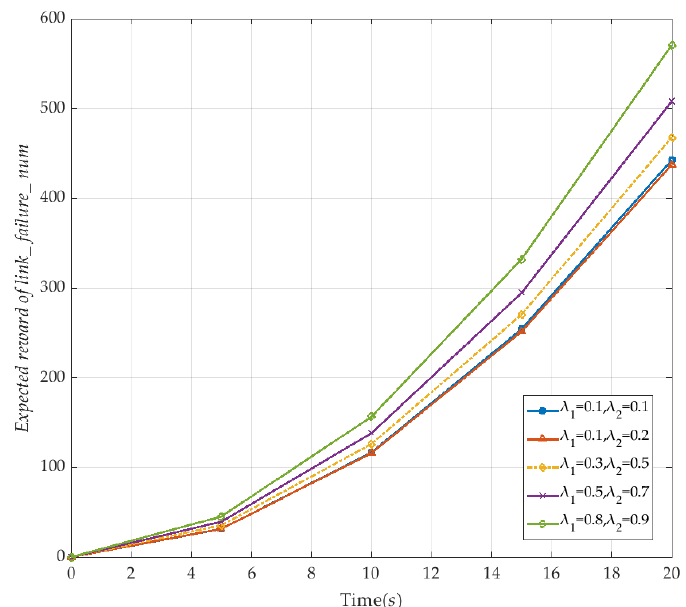
Figure 13. The expected reward of the link failure number in the V2I network with time (corresponding to λ 1 and λ 2 ).